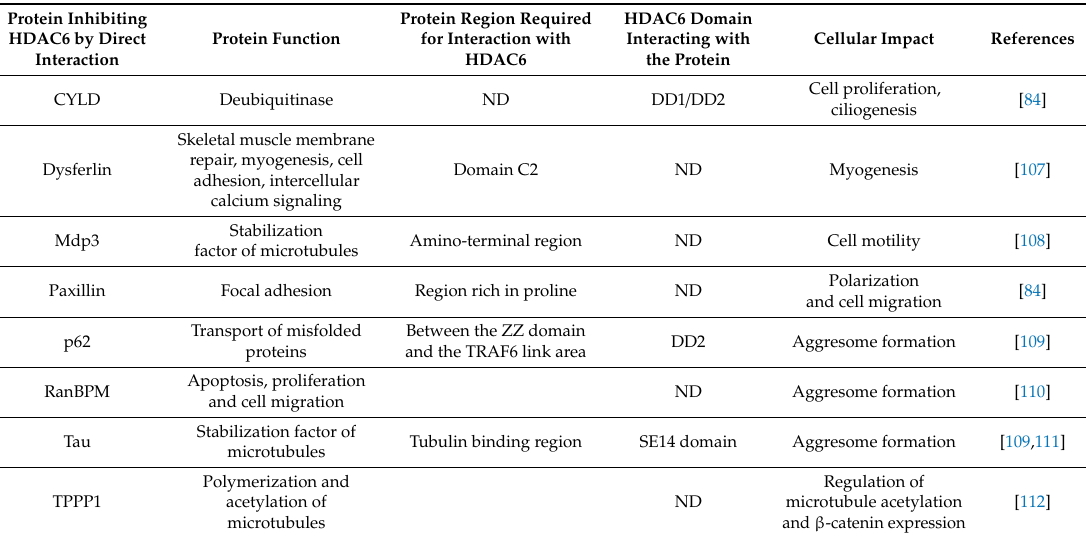
Table 6. Proteins that interact directly with the HDAC6